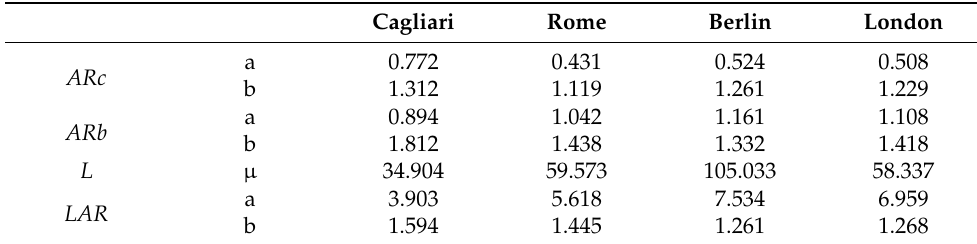
Table 2. Parameters for the proposed